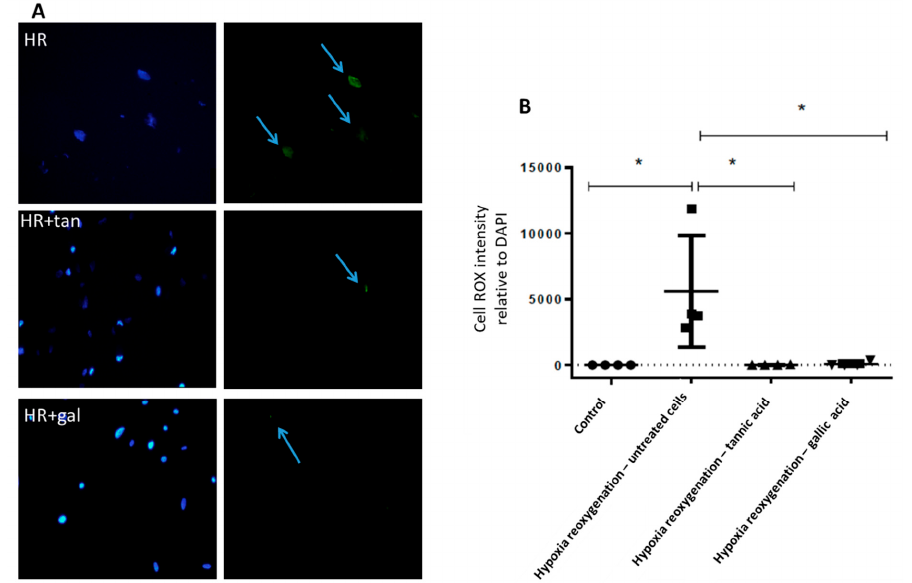
Figure 9. Tannic acid and gallic acid prevent oxidative stress induced by hypoxia – reoxygenation sequence. Reactive oxygen species production was determined by Cell ROX staining. ( A ) Representative pictures (40X) of staining in human aortic endothelial cells (HAEC) subjected to the hypoxia–reoxygenation sequence with or without tannic acid (7.3 µmol/L) or gallic acid (7.3 µmol/L); ( B ) quantitative evaluation of the staining. n = 4, values are mean ± SD, * p < 0,05.